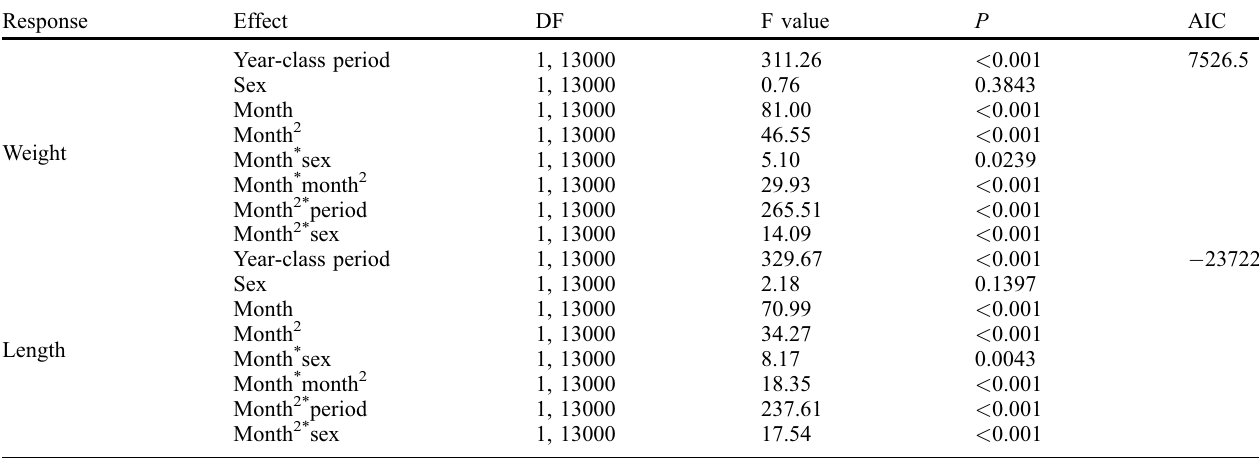
Table A.4. Growth models for 3 – 6-year-old white fi sh in the GoB.